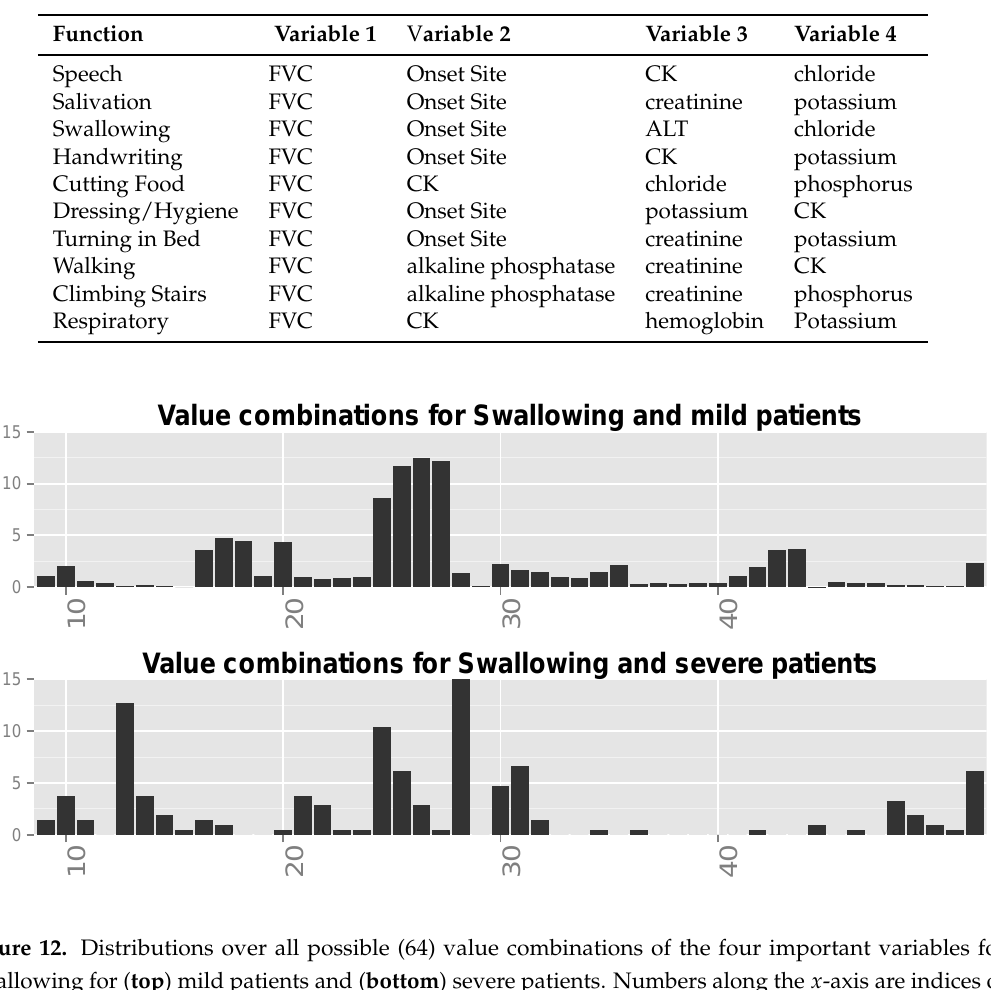
Table 6. Four important variables selected from the MB for each ALSFRS item.